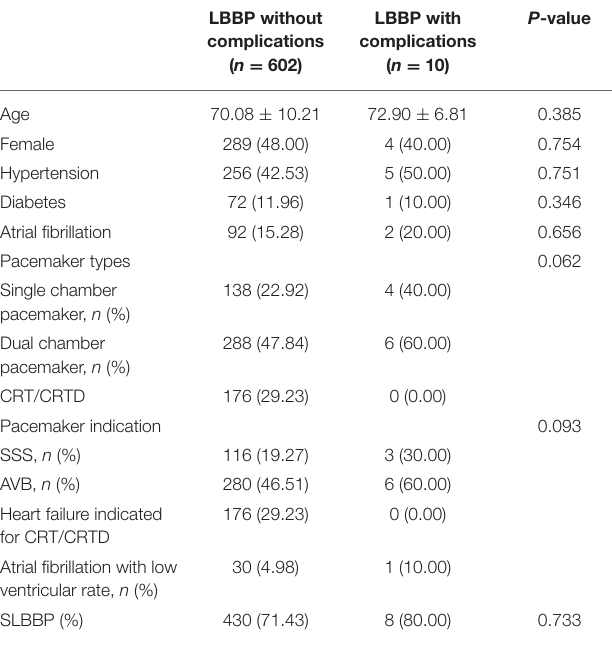
TABLE 1 | Comparisons between LBBP with and without complications.